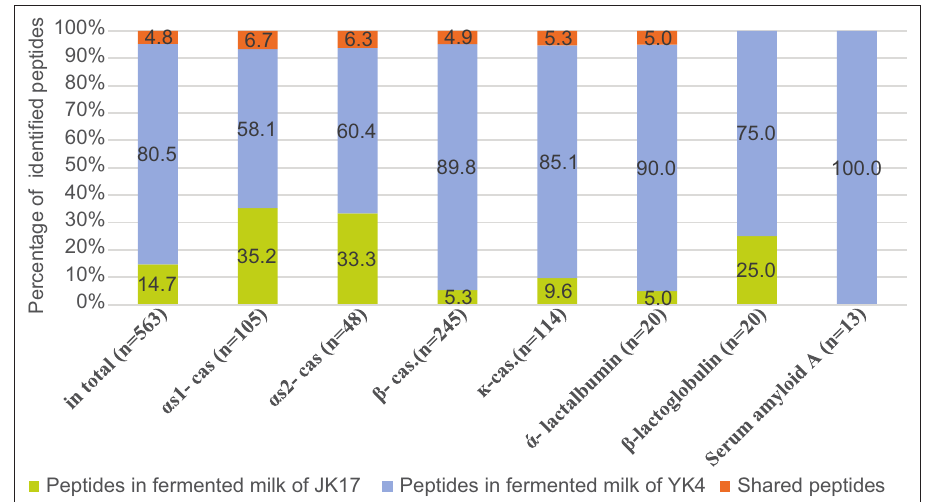
Figure-1: Distribution of identified peptides in fermented milk of Lactobacillus kefiri YK4 and JK17 in total peptides and for all parent protein, i.e., α S1-, α S2, β- and κ -casein, ά -lactalbumin, β-lactoglobulin, and amyloid